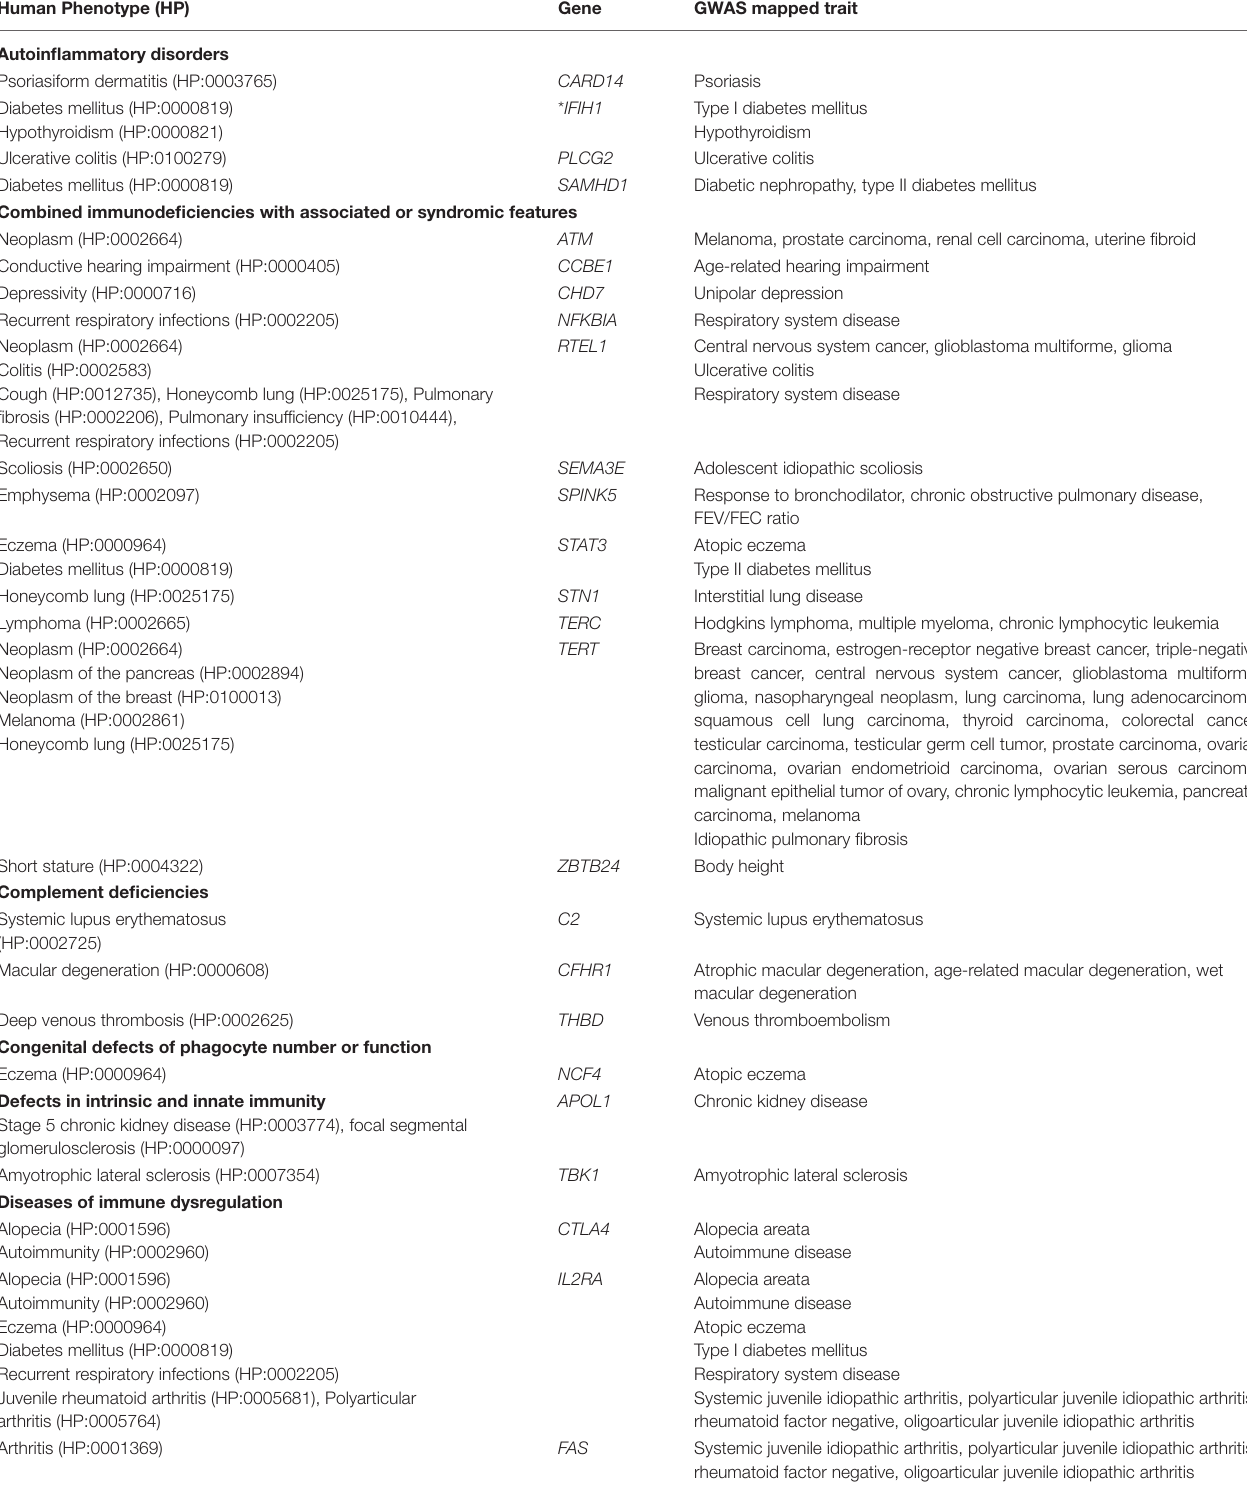
TABLE 2 | Overlap between HPO terms and GWAS mapped traits for the genes of inborn errors of